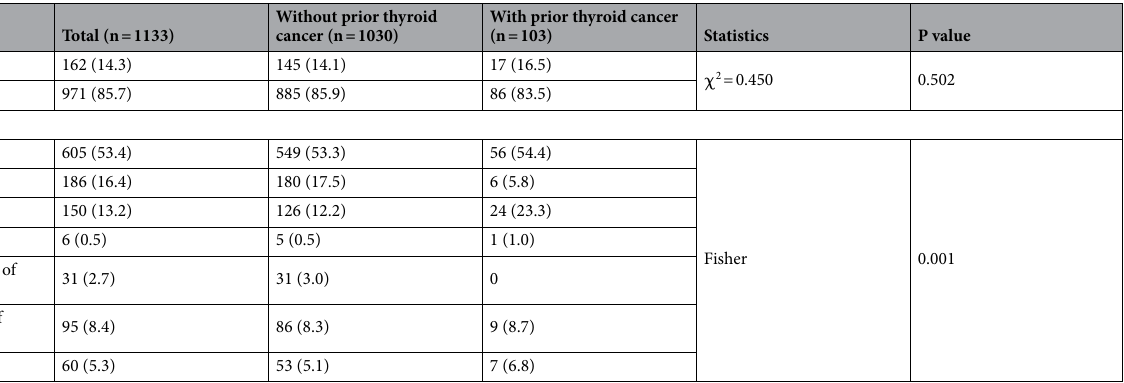
Table 1. Patients’ clinicopathological baseline information. AJCC American Joint Commission on Cancer(7th), SEER the surveillance, epidemiology, and end